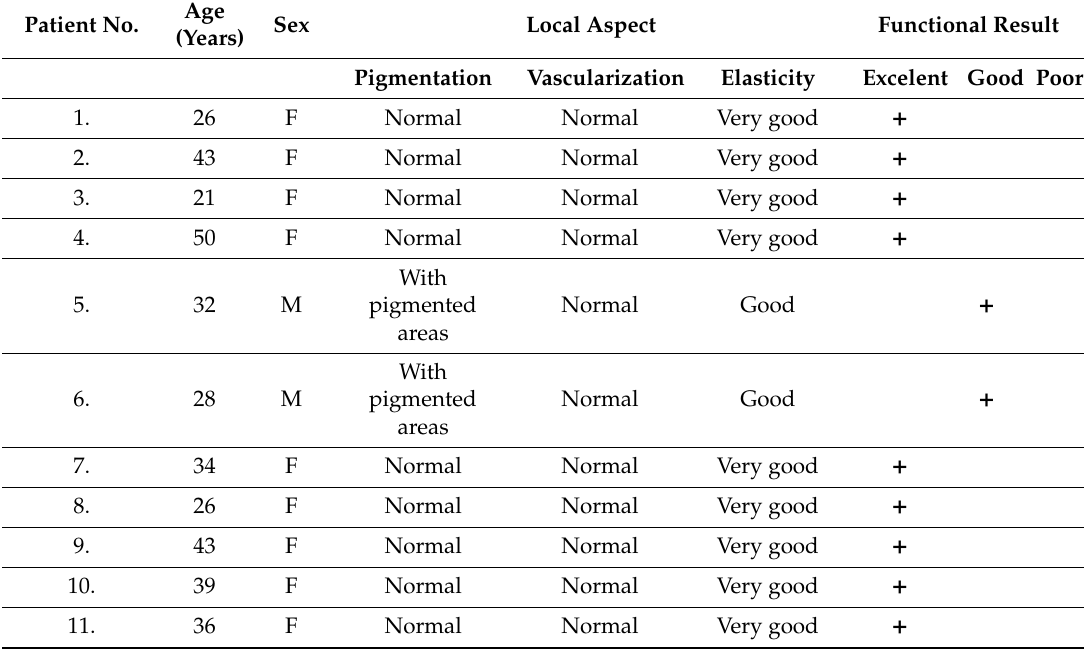
Table 2. Clinical evaluation of eleven cases after reconstruction with Integra, including local aspect and functional results.